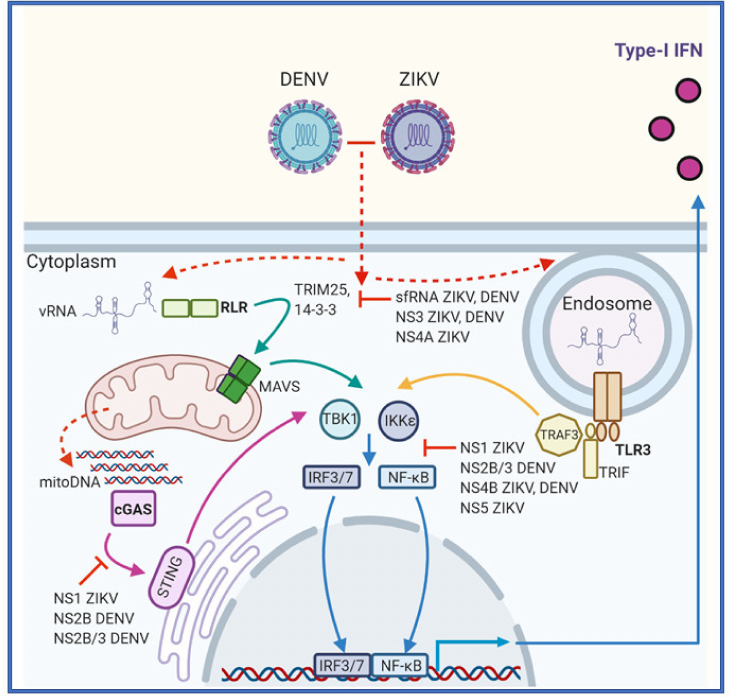
Figure 3. Recognition of Zika Virus (ZIKV) and Dengue Virus (DENV) by the innate immune system and viral evasion of pattern recognition receptor (PRR)-mediated interferons (IFN) production. ZIKV and DENV infections are sensed by multiple PRRs inside the cell. or pathogen associated molecular pattern (PAMP) vRNA from the replication stage of the virus lifecycle activates RLRs in the cytosol (green arrows) or Toll-like receptors (TLRs) in the endosome (gold arrows). Alternatively, both ZIKV and DENV infection results in release to mitoDNA into the cytoplasm that is sensed by cyclic GMP-AMP synthase (cGAS), activating stimulator of interferon genes (STING) (purple arrows). Each of these pathways leads to phosphorylation of kinases TBK1 and IKK ε that activate IRF3 / 7 and NF- κ B. These transcription factors then upregulate the production of type-I IFN β (blue arrows). However, ZIKV and DENV have evolved evasion mechanisms (red) to prevent IFN production that target multiple stages of these